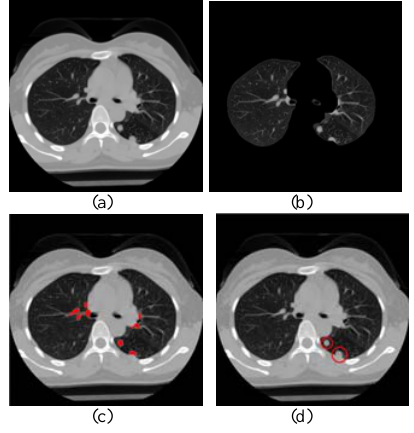
Fig. 14. Recognition results of the case including a micro- nodule. (a)CT original image, (b) Lung parenchyma segmentation, (c)ROIs extraction, (d)Classification Results.